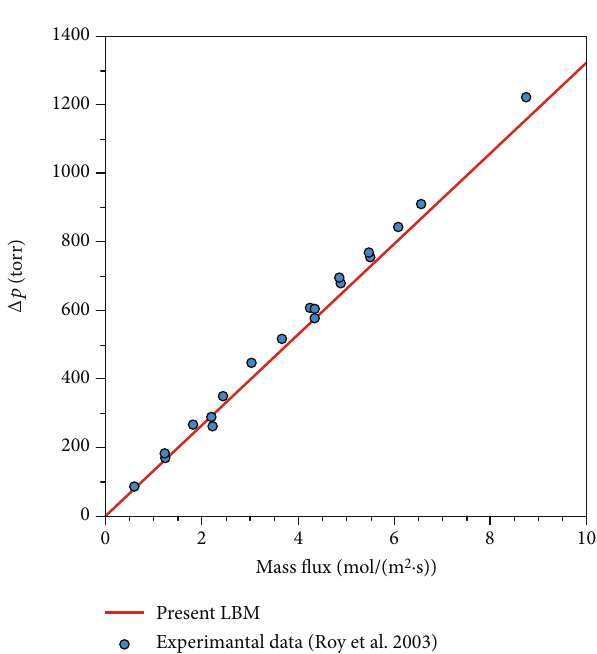
Figure 1: Comparison of LB simulation results and experimental